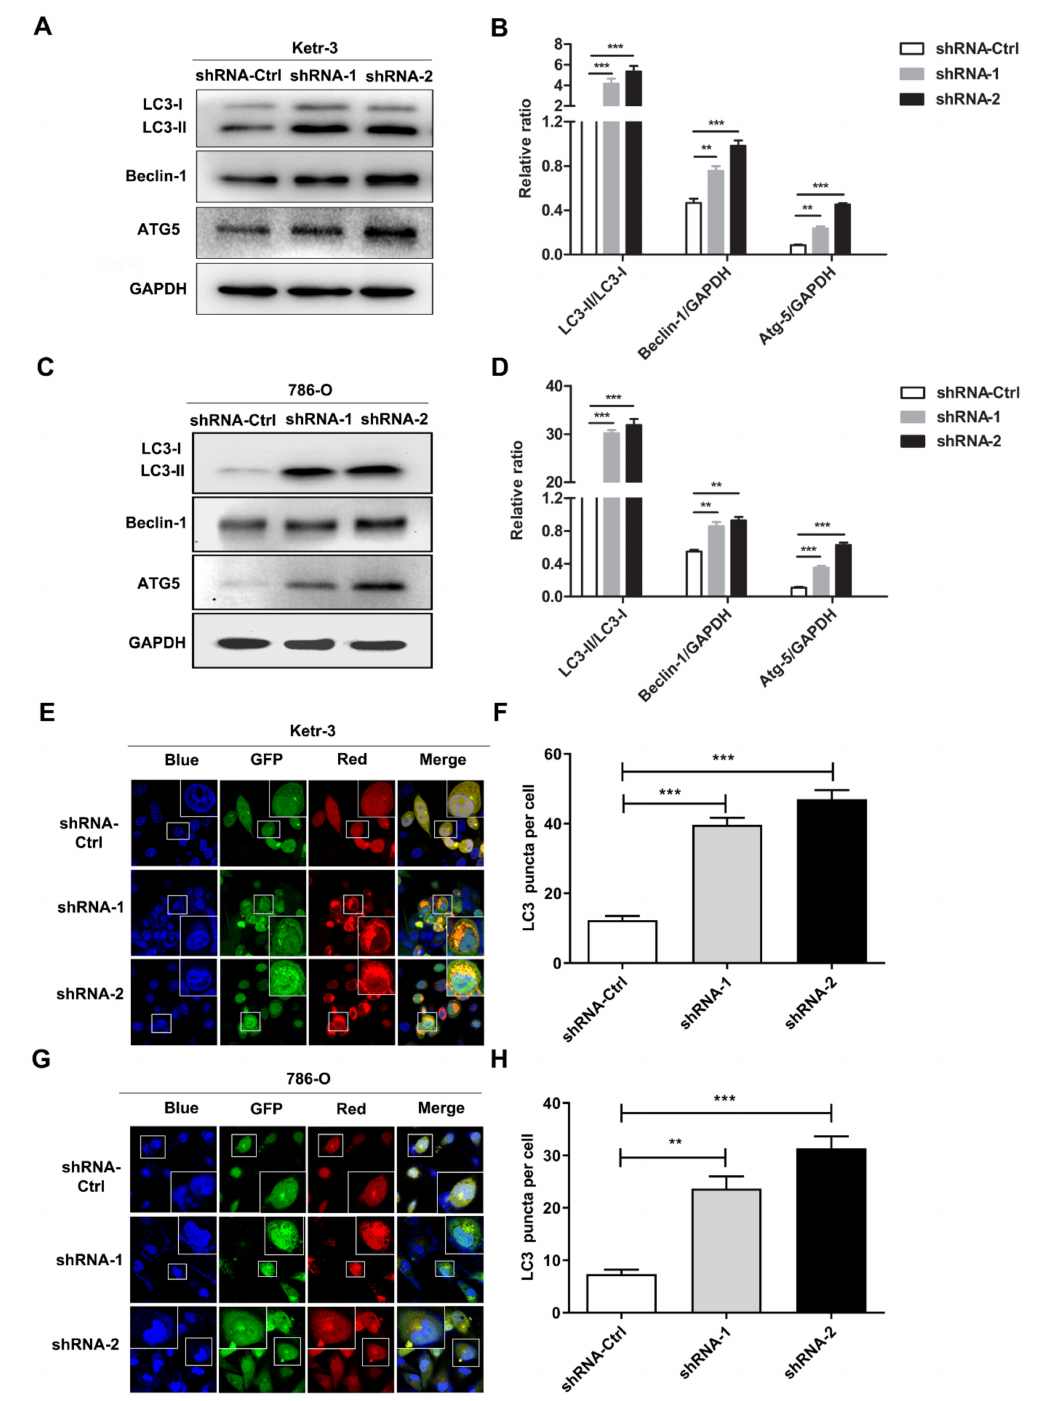
Figure 4. Knockdown of IFI35 enhanced autophagy induction in renal cancer cells. ( A , C ) The levels of LC3-I, LC3-II, Beclin-1, and ATG5 were measured by Western blot in IFI35 shRNA or shRNA-Ctrl-treated Ketr-3 and 786-O cell lines. ( B , D ) The statistical analysis of the band intensity represents a densitometric estimation of each band normalized by GAPDH in ( A , C ). ( E , G ) IFI-35 shRNA or shRNA-Ctrl-treated renal cancer cells were transfected with GFP-RFP-LC3 adenovirus and cultured for 24 h. Cells were fixed, stained with DAPI, and imaged with a 63 × oil-immersion objective lens, scale bar: 20 µ m. ( F , H ) LC3 puncta number per cell in ( E , G ) was quantified. Data are from one representative experiment of three performed and presented as the mean ± SD, cell samples, n ≥ 3. Statistical significance was set at ** p < 0.01, and *** p < 0.001. Original blots see Supplementary File